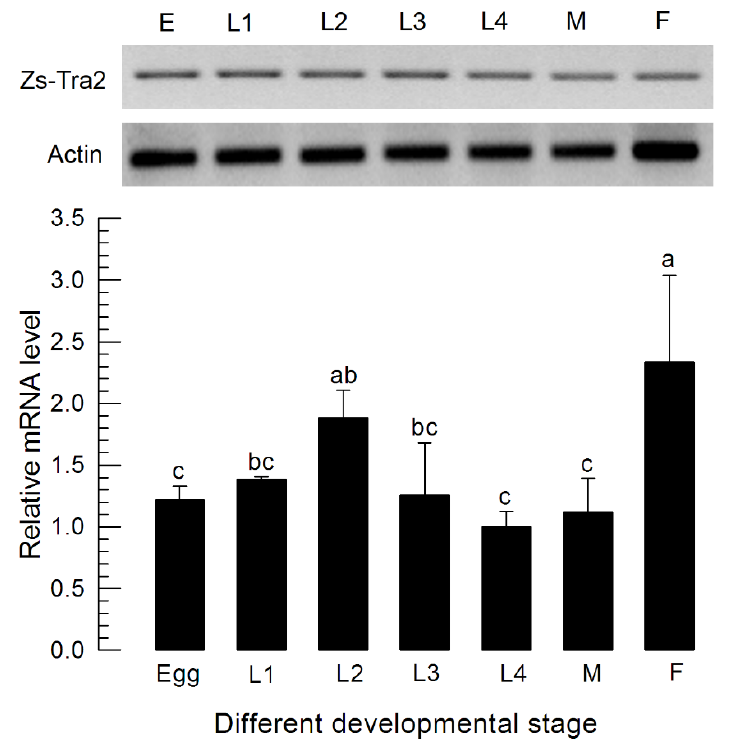
Figure 2. Expression profile of Zs-Tra2 in different developmental stages including different larval instars (‘L1–L3’), male (‘M’) adults, and female (‘F’) adults. Actin gene was used as a reference gene to normalize target gene expression level in RT-qPCR. All treatments were independently replicated three times. Different letters above standard deviation bars indicate significant difference among means at Type I error = 0.05 (LSD test).